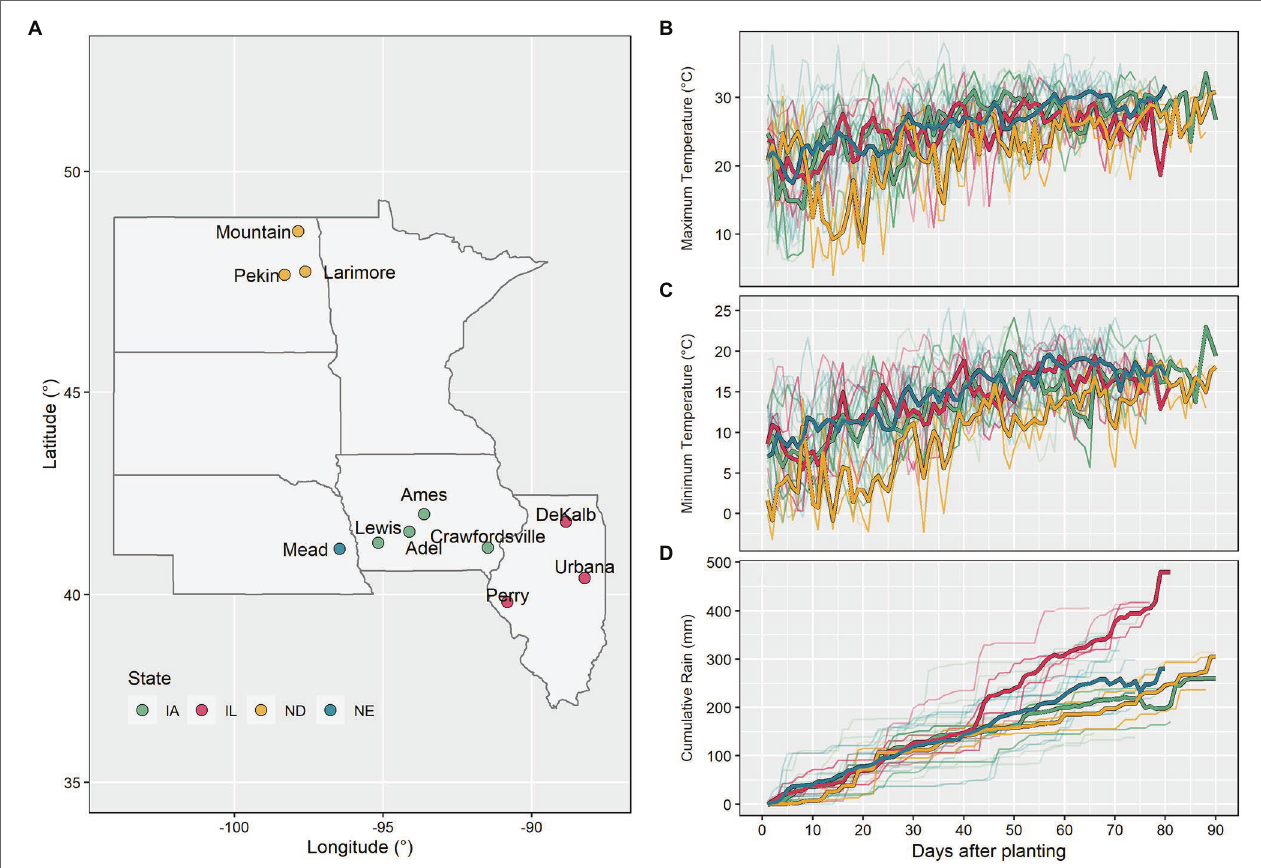
FIGURE 1 | Map with the experimental locations used in this study (A) . Maximum temperature (B) , minimum temperature (C) , and cumulative rain (D) between planting and beginning of the reproductive phase for all 98 datasets (thin lines represent individual datasets and thick lines represent the average by